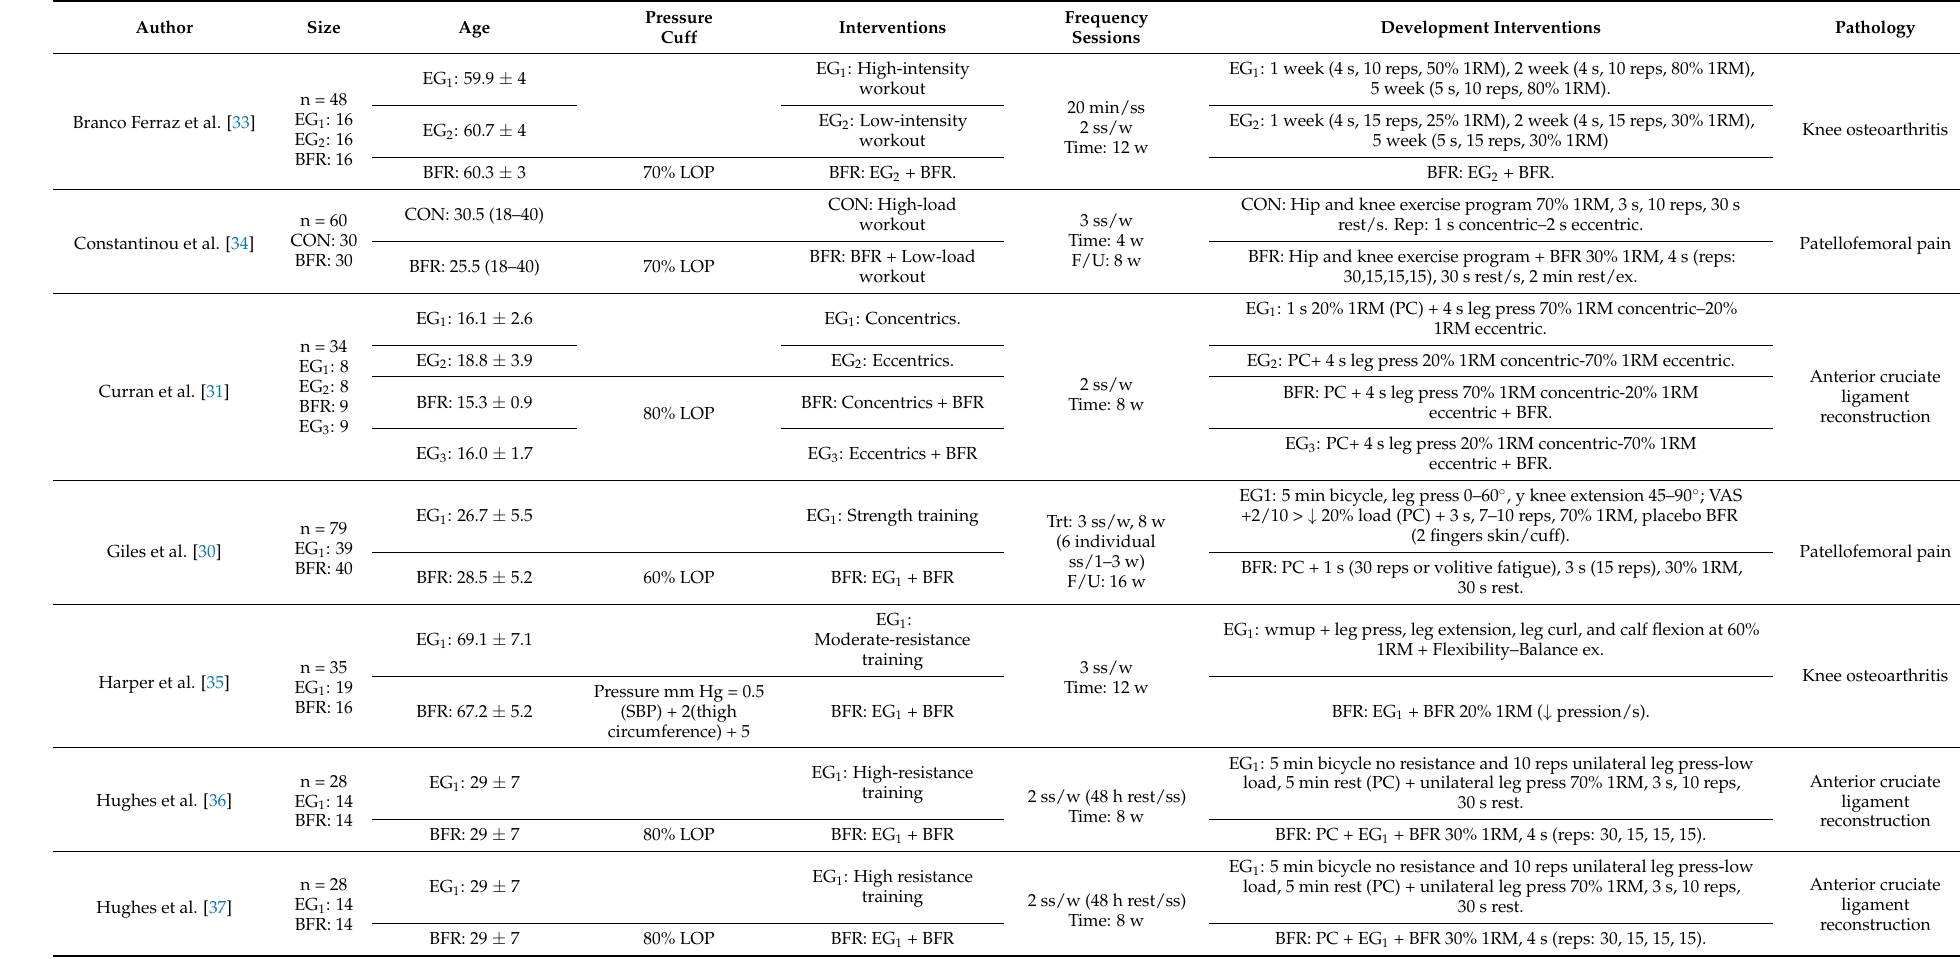
Table 2. Characteristics of the studies included in this systematic